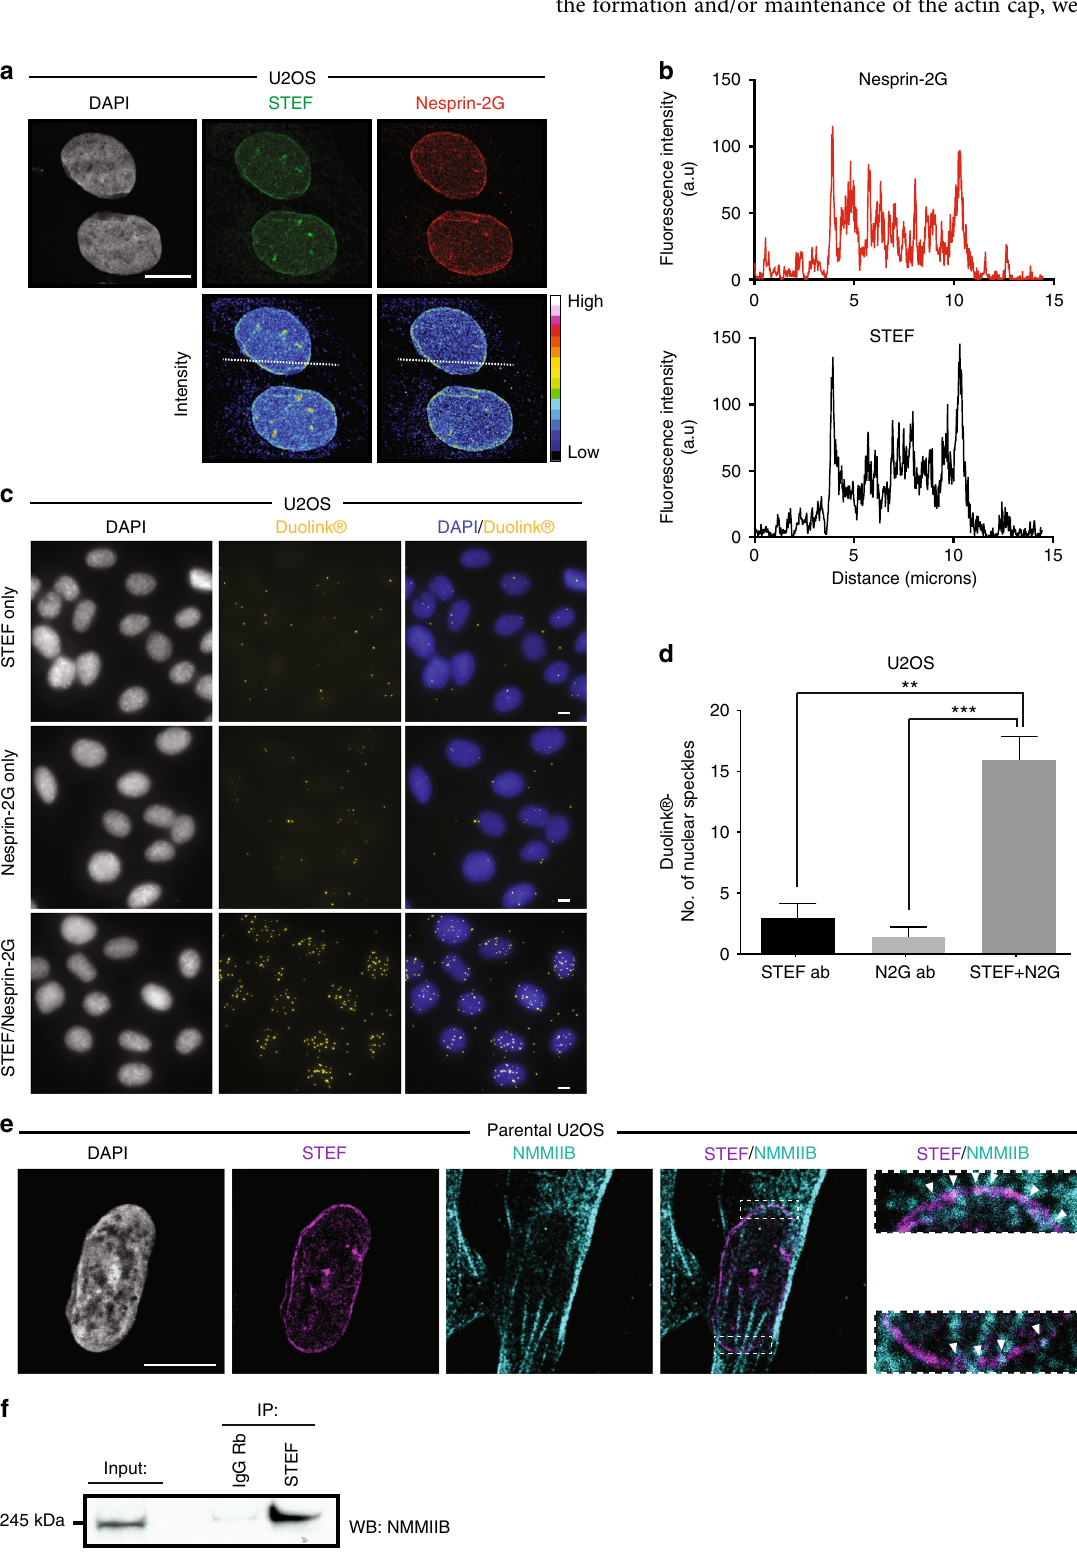
(Fig. 4a). Measurement of the FRET ratio in the perinuclear region showed a substantial decrease in perinuclear Rac1 activa- tion in the STEF-depleted CRISPR clones compared to controls